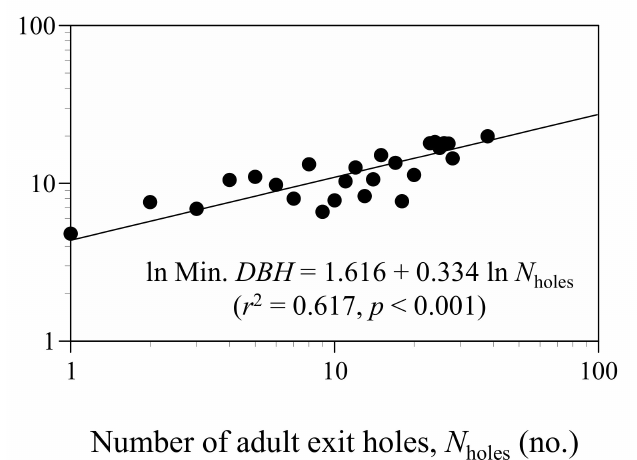
Figure 6. Relationship between the number of adult exit holes ( N holes ) and the corresponding minimum DBH of standing dead trees. We used the data from more than five individuals for each N holes to consider the deviation.